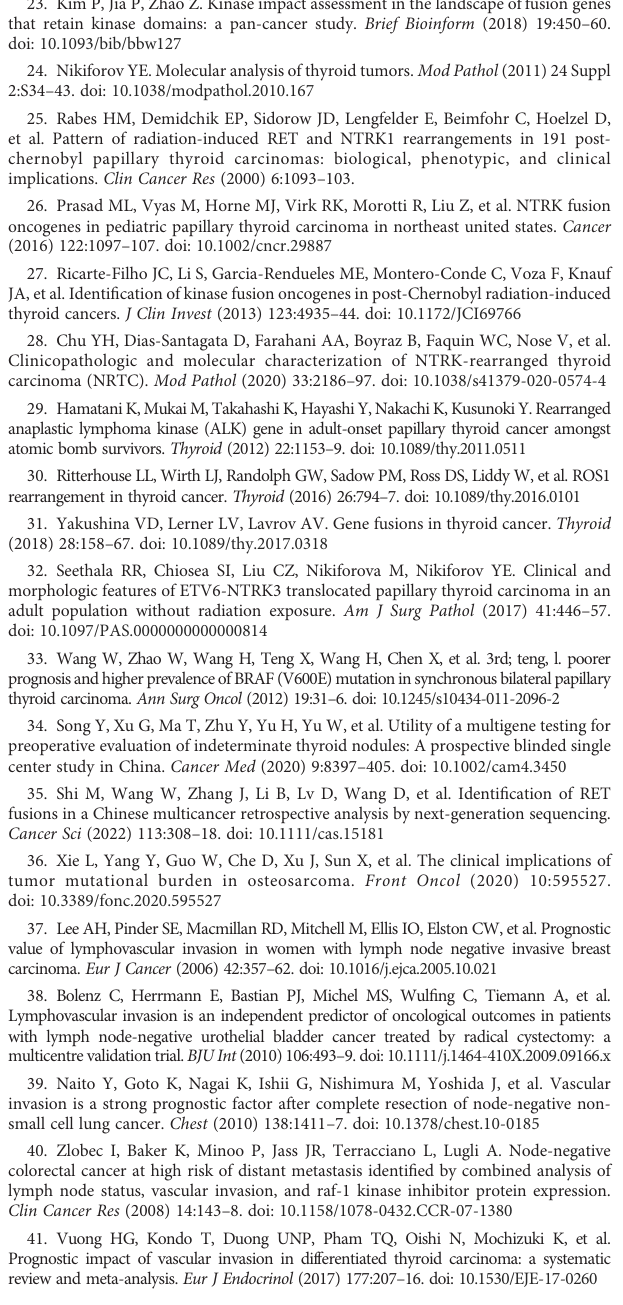
SUPPLEMENTARY FIGURE 1 The Integrative Genomics Viewer (IGV) screenshots display the reads from next-generation sequencing by Onco-Thyroid panel and reveal harbouring of gene fusions. The reference is fusion gene sequences. SUPPLEMENTARY FIGURE 2 The IGV screenshots display the reads from next-generation sequencing by Fusioncapture panel and reveal harbouring of gene fusions. The reference is GRCh37/hg19.